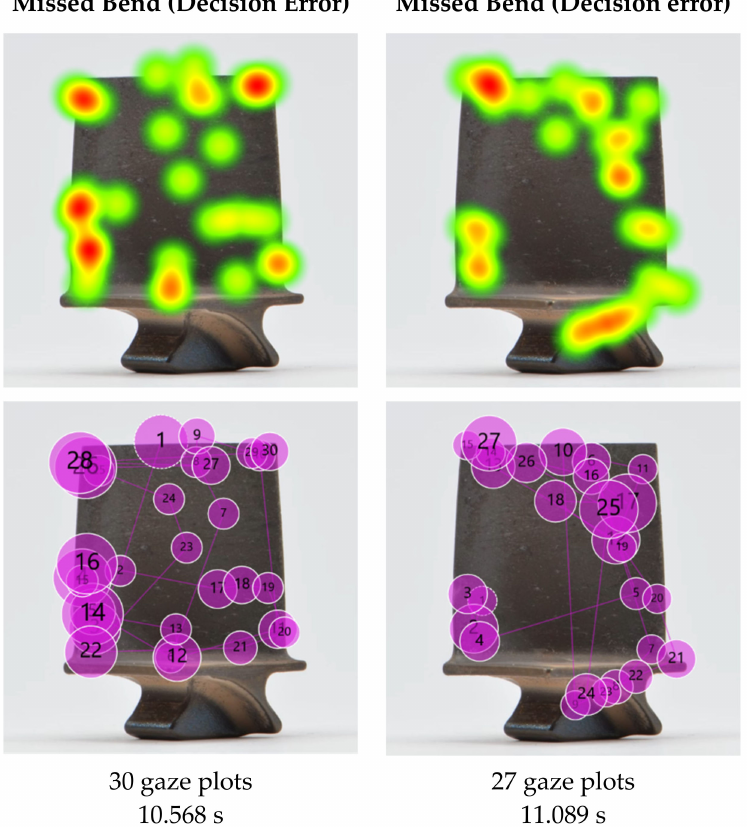
Figure 24. Two participants missed the defect from the most favourable blade